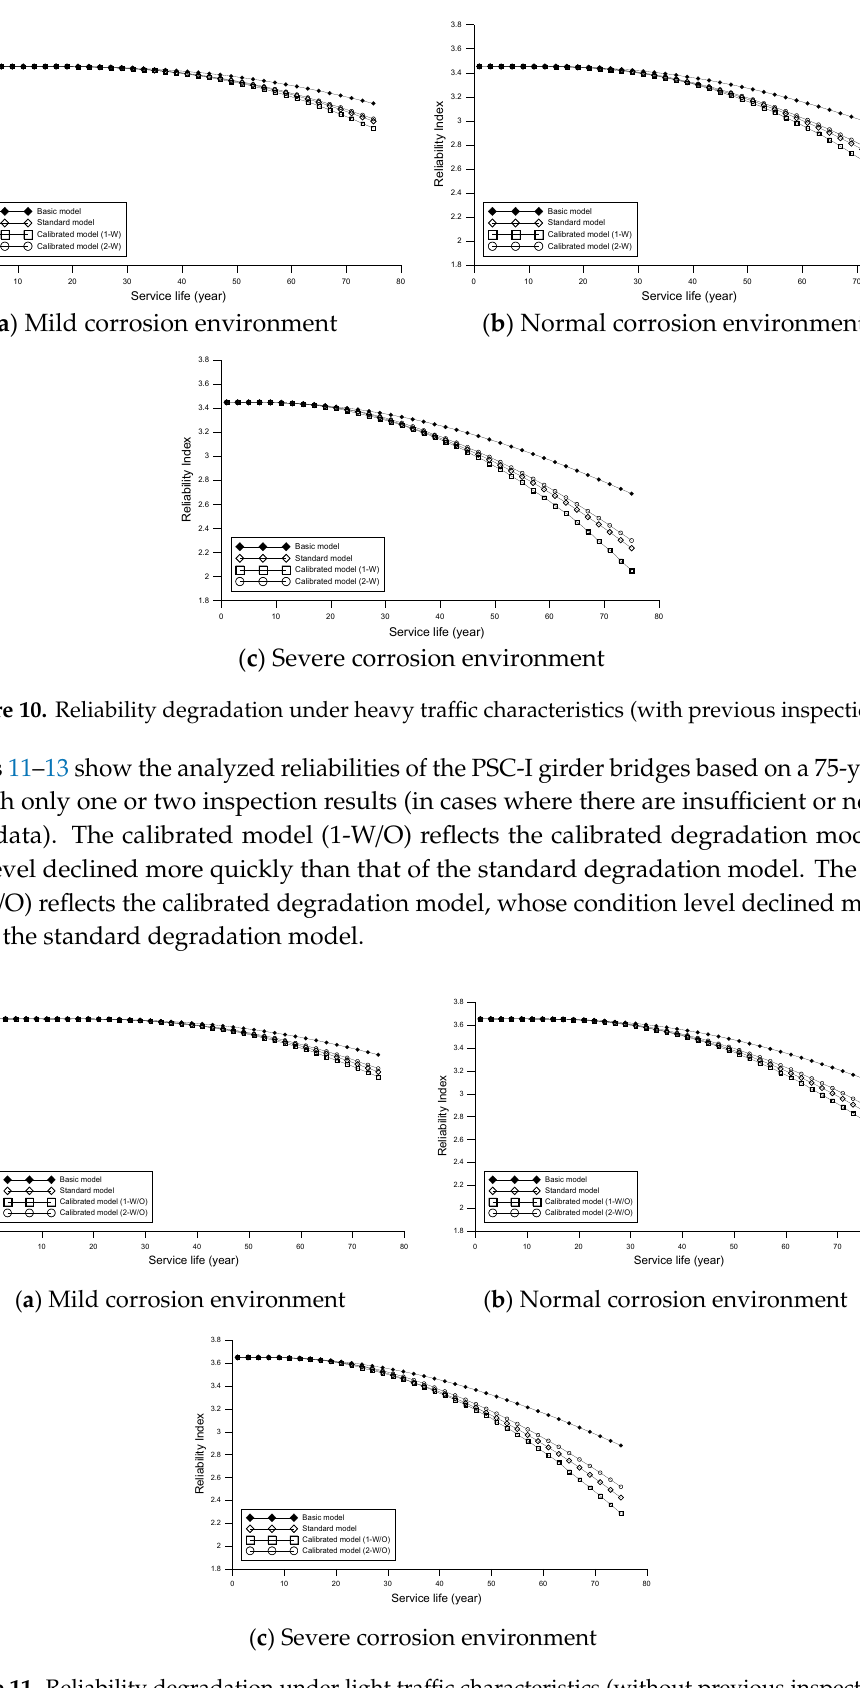
Figure 9. Reliability degradation under normal traffic characteristics (with previous inspection).